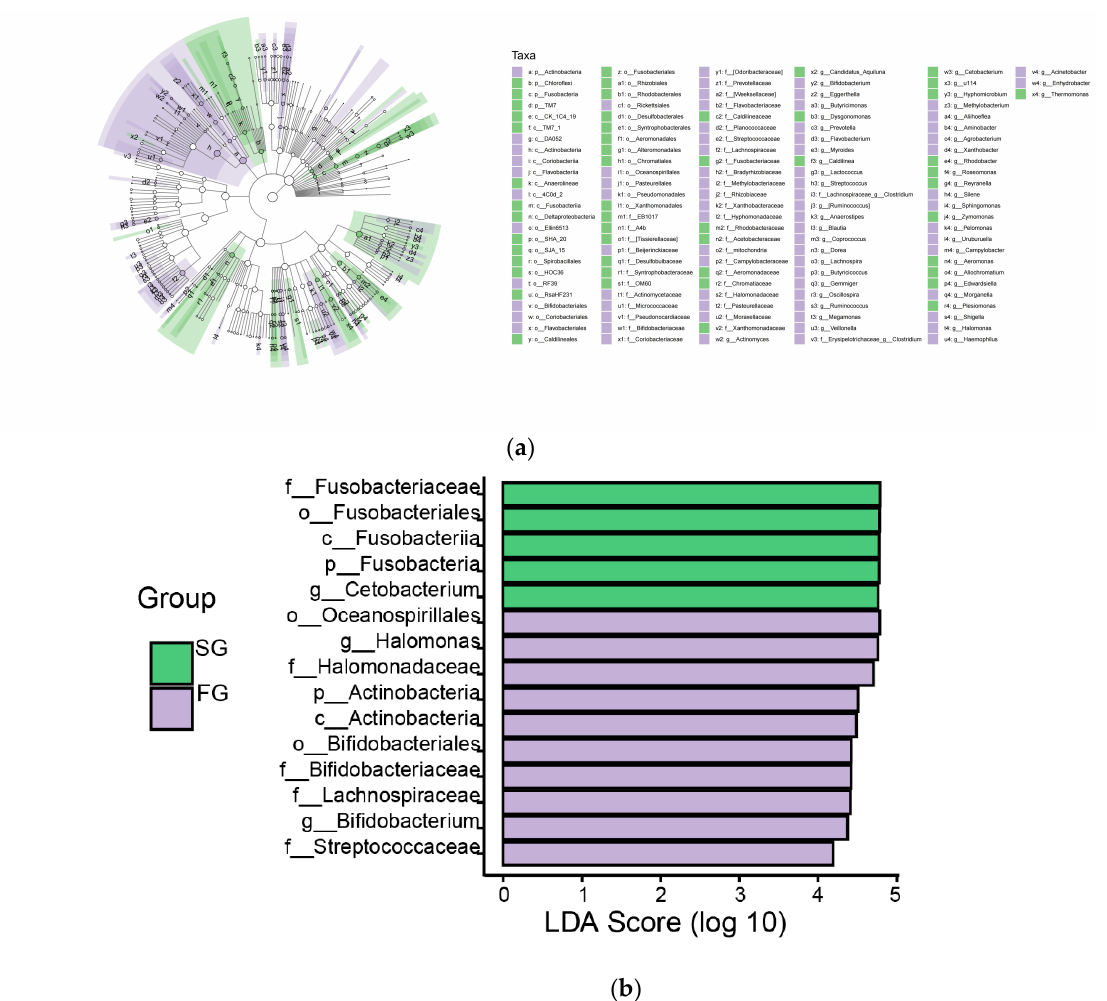
Figure 5. ( a ) Linear discriminant analysis effect size (LEfSe) results showing differences in the gut flora between the fast-growing (FG) and slow-growing (SG) groups of juvenile largemouth bass; ( b ) LDA score > 4, p ≤ 0.05.